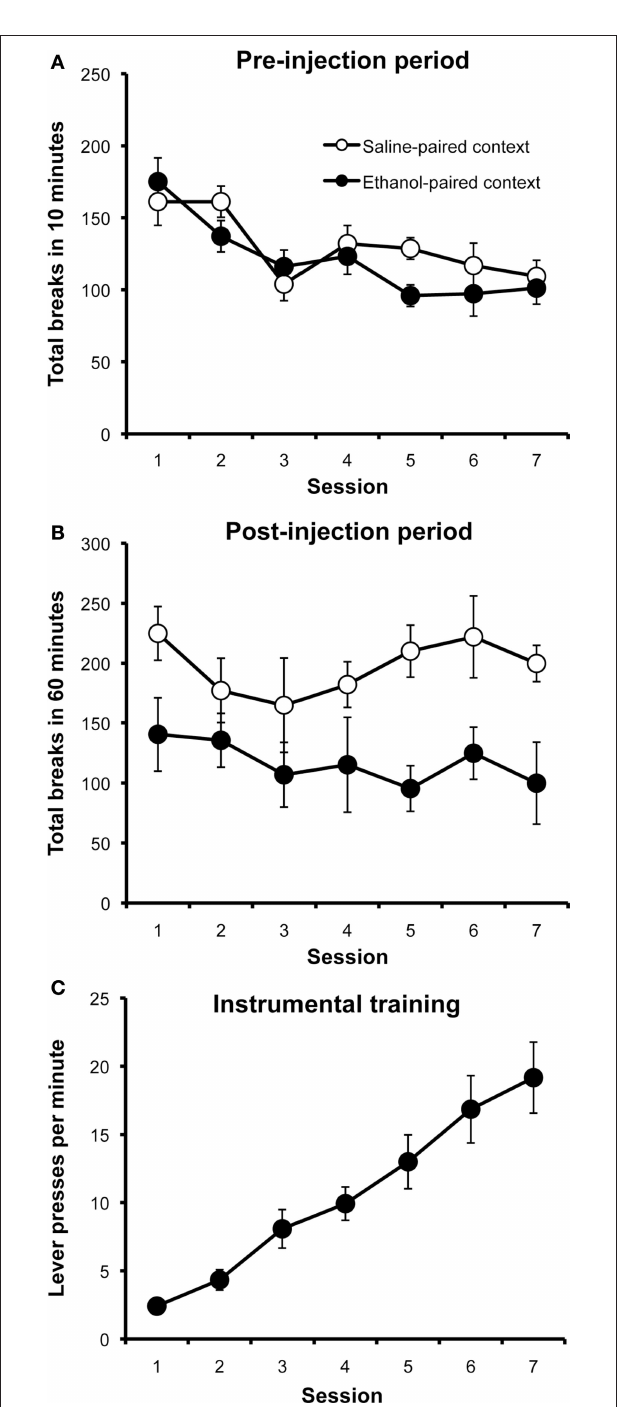
FIgure 1 | Context conditioning and instrumental training results (experiment 1). Mean photobeam breaks ( ± SEM) during the 10-min pre-injection period (A) and the 60-min post-injection period (B) over days, plotted separately for saline and ethanol injection sessions. Mean rate of lever pressing ( ± SEM) over successive instrumental conditioning sessions (C)